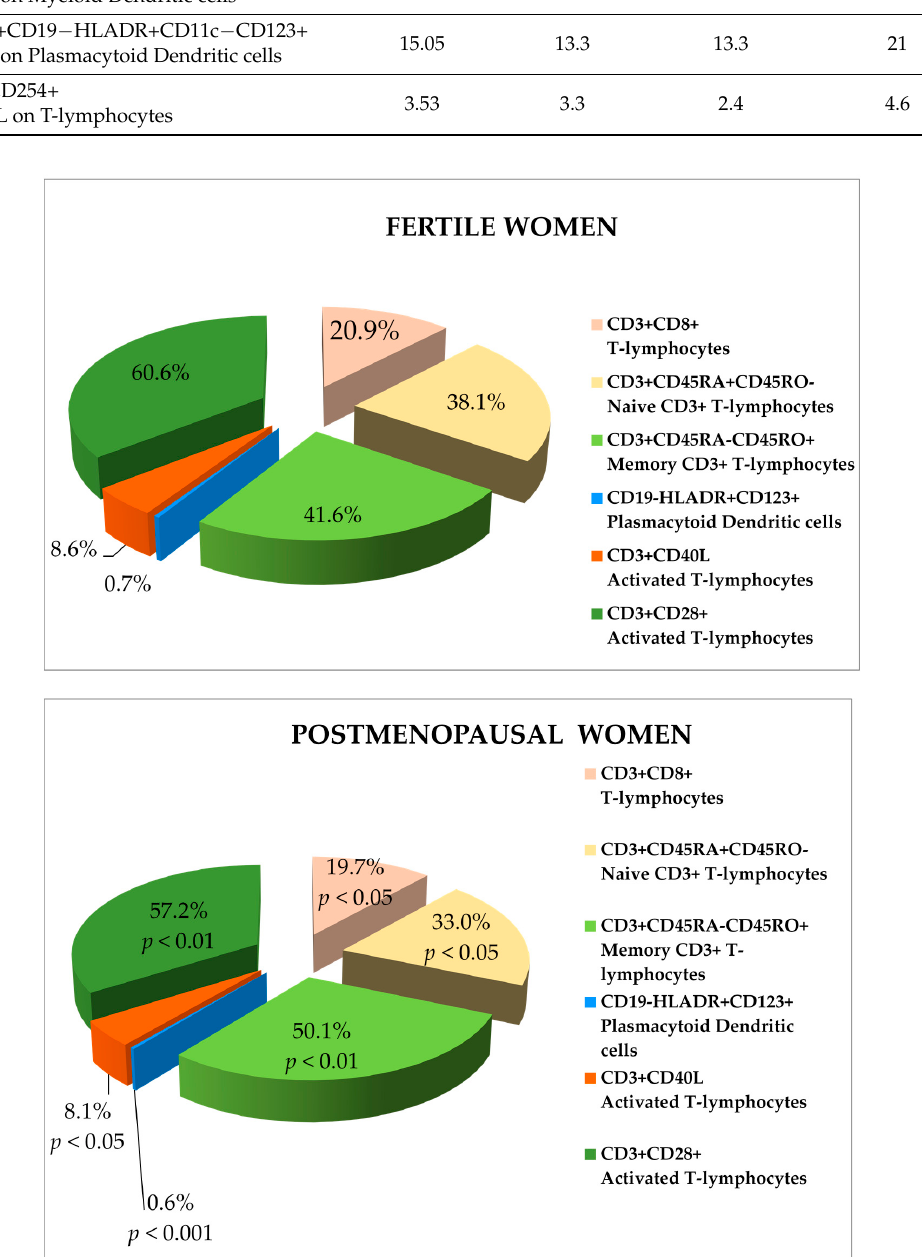
Figure 1. Comparison of the cell surface markers expression (%) in whole blood of fertile and postmenopausal women with statistical significant differences. CD = cluster of differentiation. The postmenopausal women presented significantly lower percentage of CD3+CD8+ T-lymphocytes, naive CD3+ T-lymphocytes and CD3+CD40L+ activated T-lymphocytes ( p < 0.05), CD3+CD28+ activated T-lymphocytes ( p < 0.01), plasmacytoid DCs ( p < 0.001), and higher percentage of memory CD3+ T-lymphocytes ( p < 0.01), compared to fertile women.